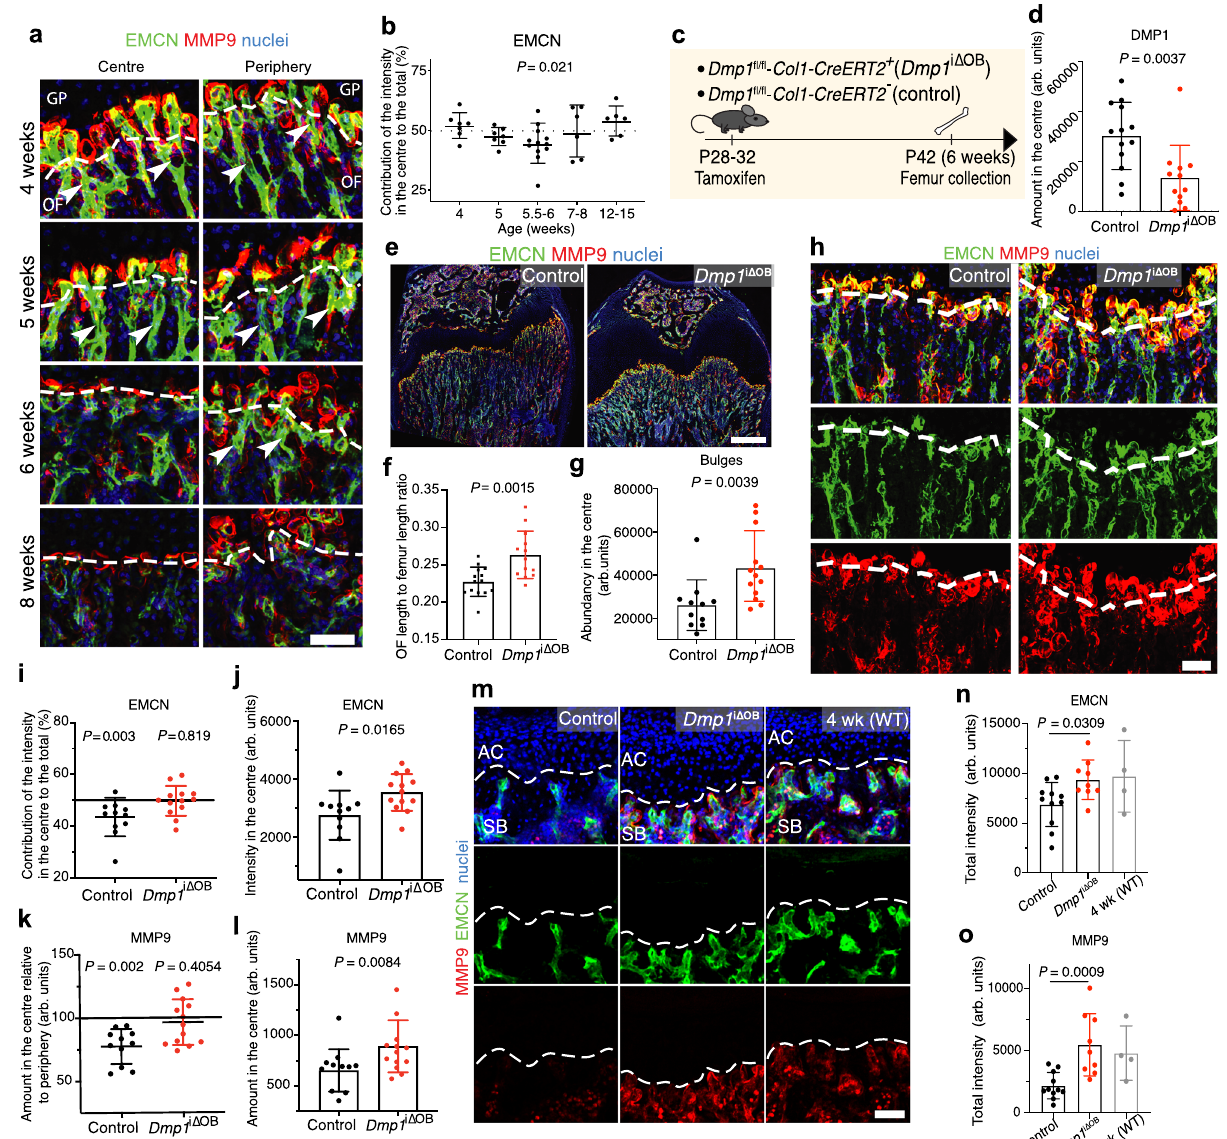
Fig. 2 DMP1 transforms active type H vessels into quiescent type L in the OF and in subchondral bone. a EMCN and MMP9 immunostaining of femur. Dashed line shows the OF-GP border. White arrows point at type H vessels. Scale bar 50 µ m. b Quanti fi cation of the contribution of the central and peripheral parts to the total EMCN intensity. At 4- and 5-weeks n = 7, 5.5 – 6 weeks n = 12, 8 weeks n = 6, 12 – 15 weeks n = 6. Pooled data from six independent experiments. P value shows the signi fi cance between the intensity in the centre versus periphery for every mouse (two-tailed paired t -test). Mean± SD. c Experimental scheme to induce Dmp1 deletion by Tamoxifen injection. d Quanti fi cation of DMP1 amount in the OF centre of control and osteoblast-speci fi c inducible Dmp1 -deleted ( Dmp1 i Δ OB ) mice. Two-tailed Mann – Whitney test. e EMCN and MMP9 immunostaining of 6-week-old control and Dmp1 i Δ OB femurs. Scale bar 500 µ m. f Quanti fi cation of ossi fi cation front length to femur length ratio in control and Dmp1 i Δ OB mice. d , f Control n = 14, Dmp1 i Δ OB n = 13. g Quanti fi cation of bulges by measuring the total EMCN intensity in the central GP in control and Dmp1 i Δ OB mice. Two-tailed Mann – Whitney test. h EMCN and MMP9 immunostaining of femur in 6-week-old control and Dmp1 i Δ OB mice. Dashed line shows the OF-GP border. Scale bar 50 µ m. i Quanti fi cation of the central to peripheral intensity ratio of EMCN in control and Dmp1 i Δ OB OF. j Quanti fi cation of the total central EMCN intensity in control and Dmp1 i Δ OB group. k Quanti fi cation of MMP9 at the OF-GP border in control and Dmp1 i Δ OB femurs. i – k Two-tailed paired t -test. l Quanti fi cation of the total central MMP9 amount at the OF-GP border in control and Dmp1 i Δ OB group. Two-tailed Mann – Whitney test. g – l Pooled data from three independent experiments. Control n = 11, Dmp1 i Δ OB n = 13. Age: 6 weeks. Mean ± SD. m EMCN and MMP9 immunostaining of 6-week-old control, Dmp1 i Δ OB and 4-week-old WT subchondral bone (SB) with articular cartilage (AC). Dashed line indicates the SB-AC border. Scale bar 50 µ m. n Quanti fi cation of the total EMCN intensity at the SB-AC border. o Quanti fi cation of the total MMP9 intensity around the vessels at the SB-AC border. m – o Pooled data from two independent experiments. Control n = 11, Dmp1 i Δ OB n = 9, 4-week-old WT n = 4. Mean ± SD. b , d , f , g , j – l , n , o Source data are provided in Source Data fi